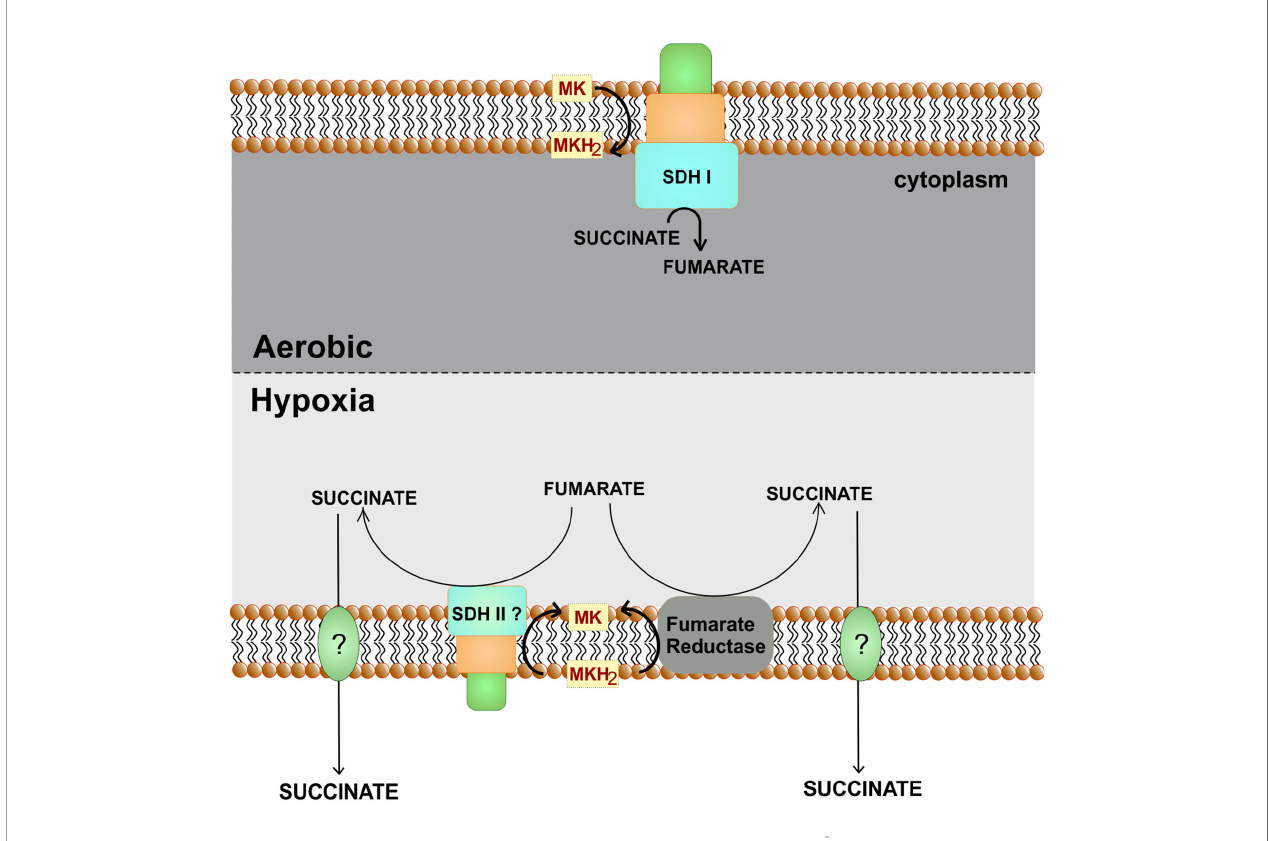
FIGURE 7 | Role of fumarate reductase/succinate dehydrogenase as an alternate respiratory pathway. Under hypoxic conditions, fumarate can act as an alternate electron acceptor. For this either fumarate reductase is utilized or succinate dehydrogenase perform the reverse reaction. Succinate is secreted out of the